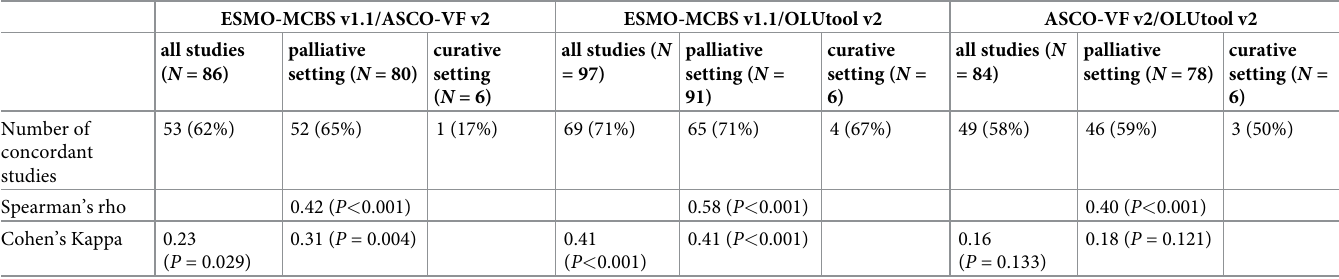
Table 2. Concordance and correlation between the different